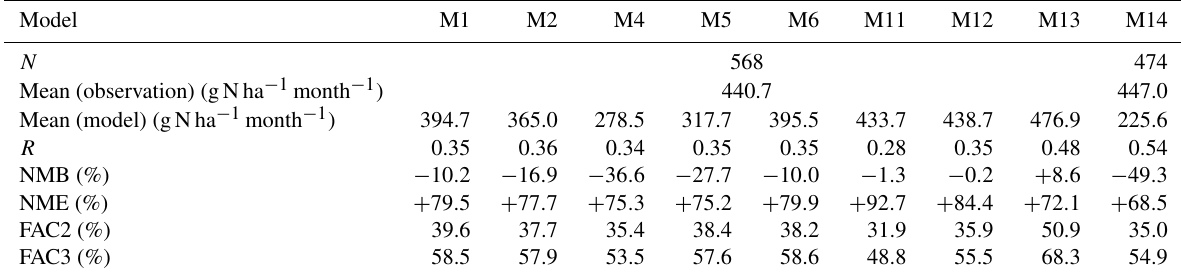
Note: models M1, M2, M4, M5, M6, M11, and M12 were based on the unified meteorological field of WRF. Model M13 was based on a different meteorological model (GEOS-5), and the covered domain was also different (see Fig. 8). Model M14 was based on a different meteorological model (RAMS), and the covered domain was